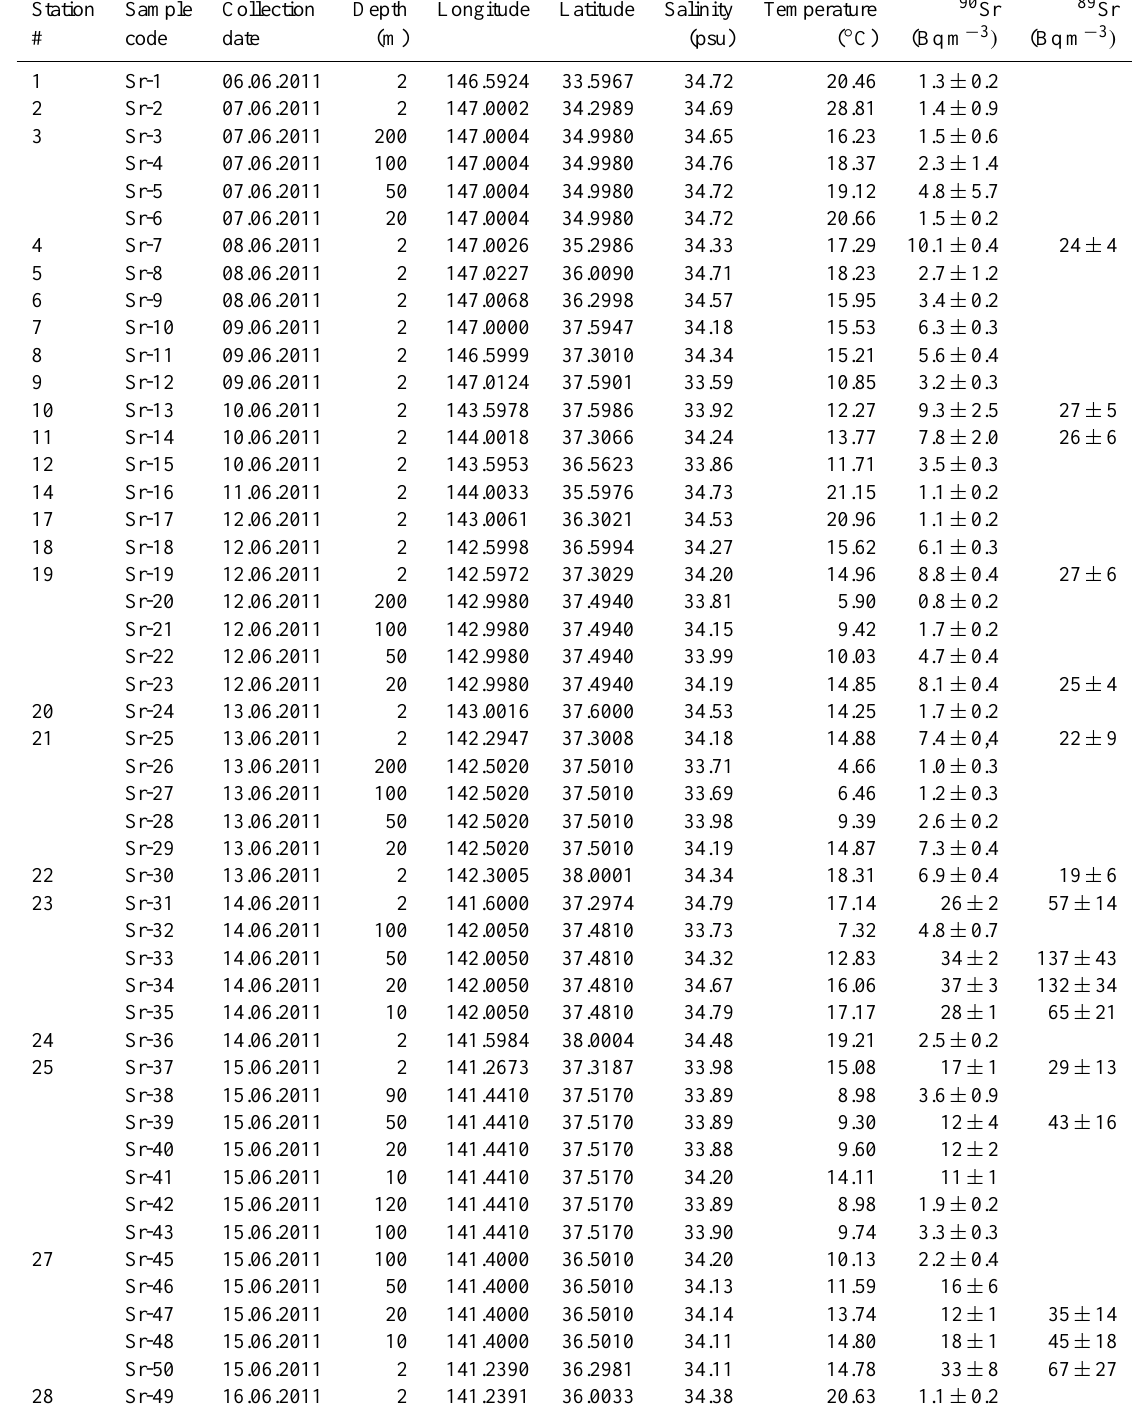
Table 1. Concentrations of 90 Sr and 89 Sr in seawater samples collected off Fukushima in June 2011. Information on collection date location, depth, salinity and temperature is also provided. All activities refer to sampling date. 90 Sr activities reported here correspond exclusively to the samples measured following the method described in Sect.